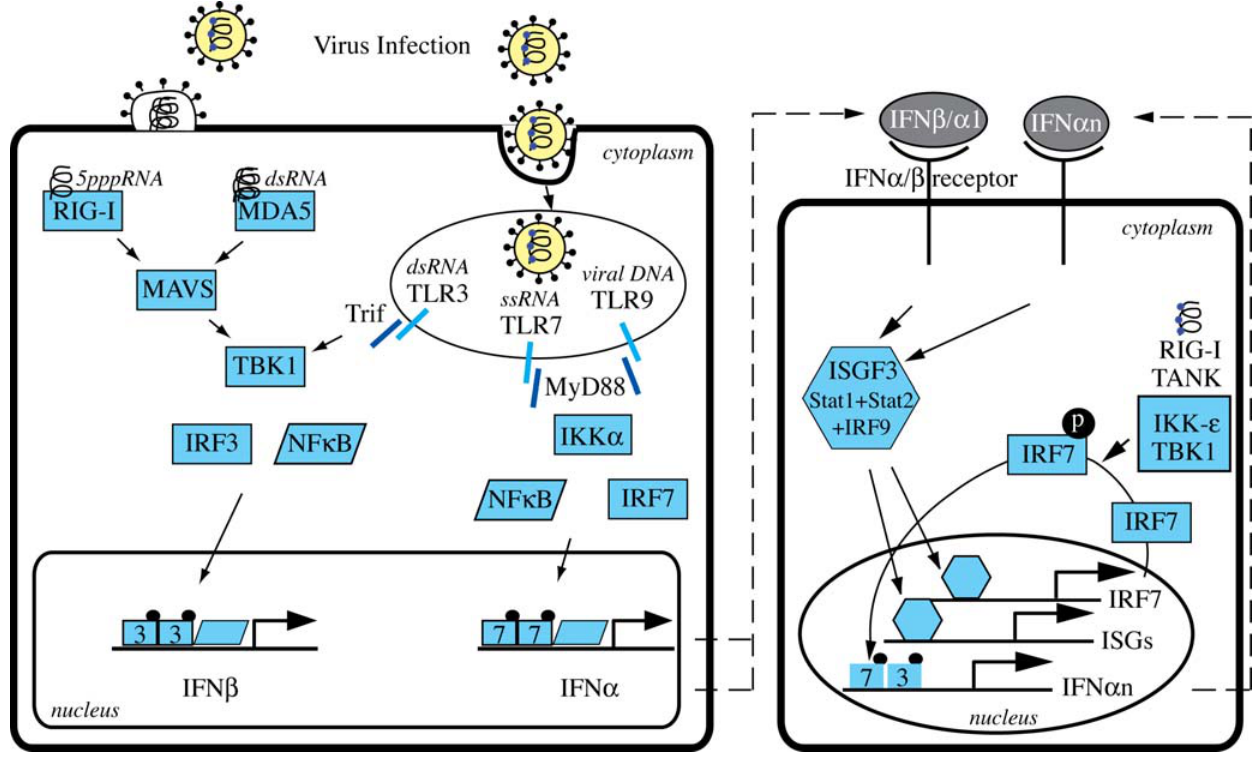
Figure 1. Induction of IFN β by viral